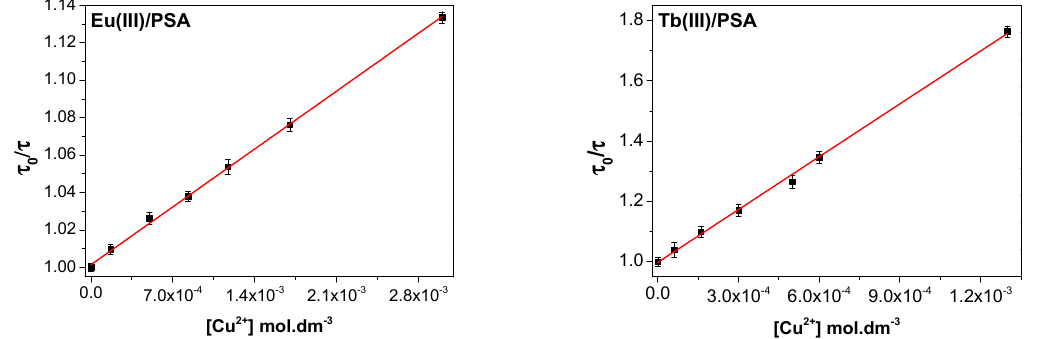
Figure 6. Stern-Volmer plot of Eu 3+ /PSA and Tb 3+ /PSA lifetimes with different Cu 2+ concentrations.